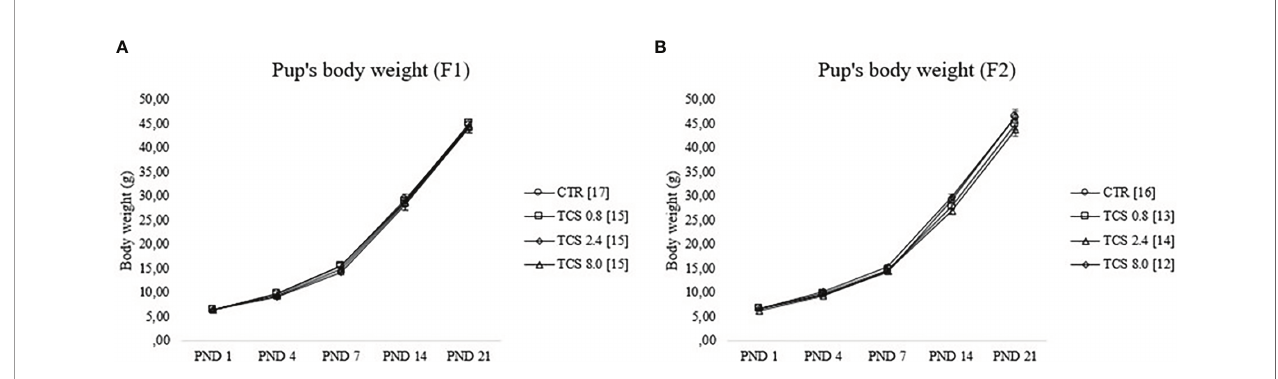
FIGURE 3 | Pup ’ s body weight gain of male rats during lactational period [from postnatal day (PND) 1 until PND 21]. (A, B) represent data of F1 and F2 males, respectively. Data were reported as means ± SEM, n =12 – 17/group, p>0.05 (RMANOVA). CTR group, treated with corn oil; TCS 0.8 group, treated with triclosan at a dose of 0.8 mg/kg; TCS 2.4 group, treated with triclosan at a dose of 2.4 mg/kg; and TCS 8.0 group, treated with triclosan at a dose of 8.0 mg/kg.